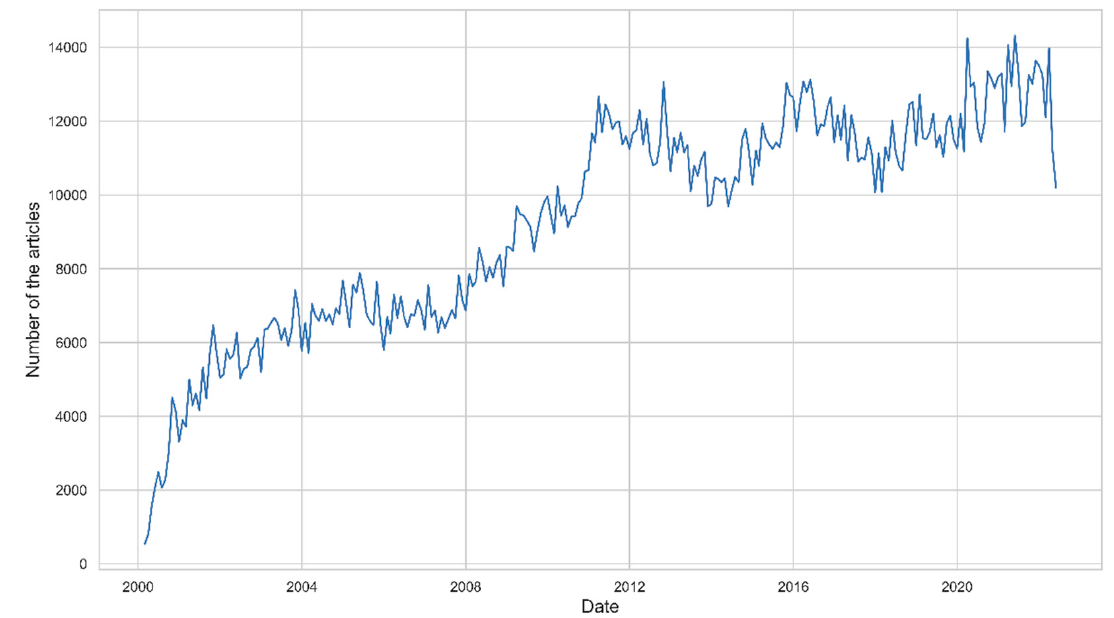
Figure 4. Monthly number of articles over time.